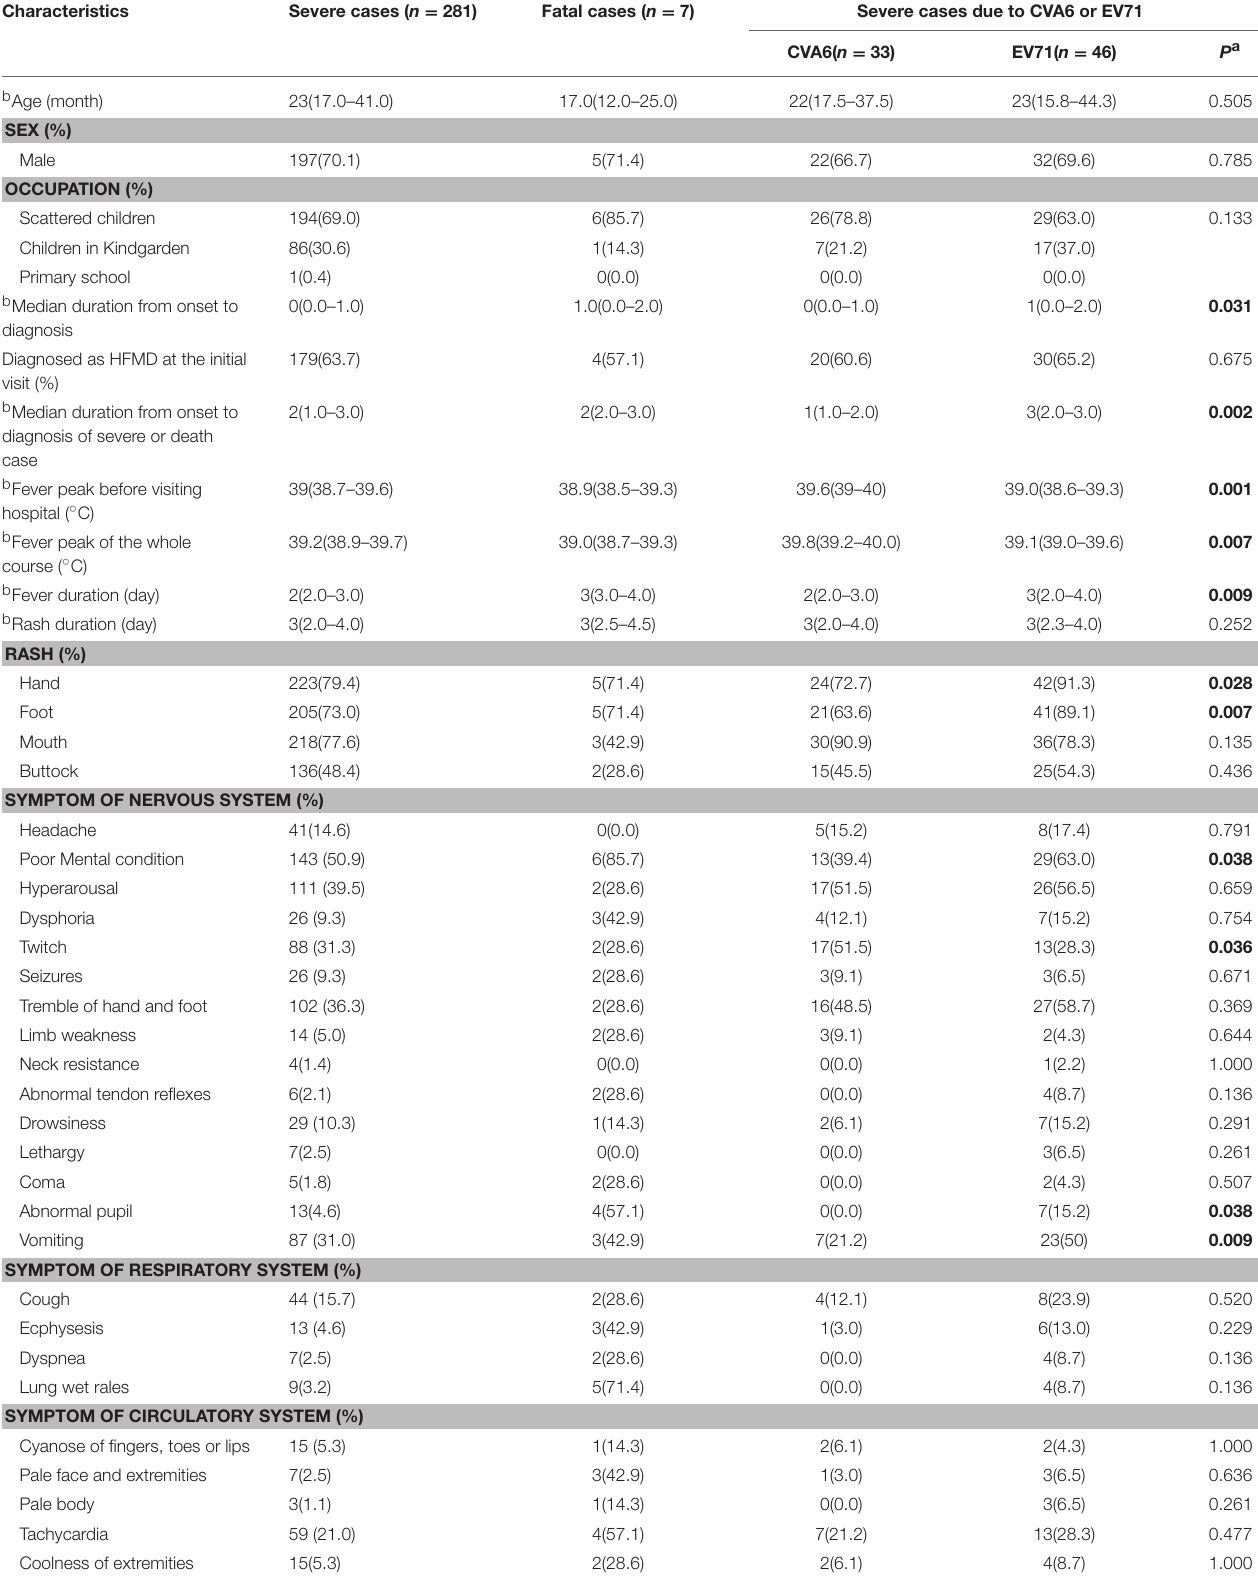
TABLE 4 | Epidemiology and clinical features of CVA6- and EV71- associated severe HFMD cases.